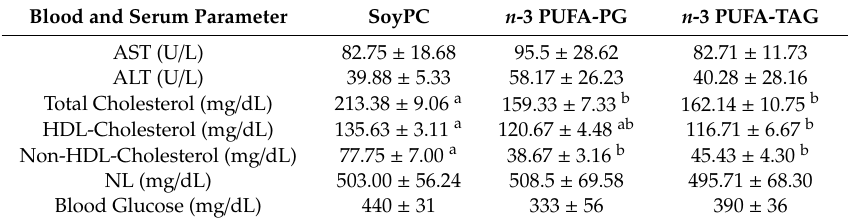
Table 3. Blood and serum parameters of KK- A y mice fed the experimental diets. Blood and Serum Parameter